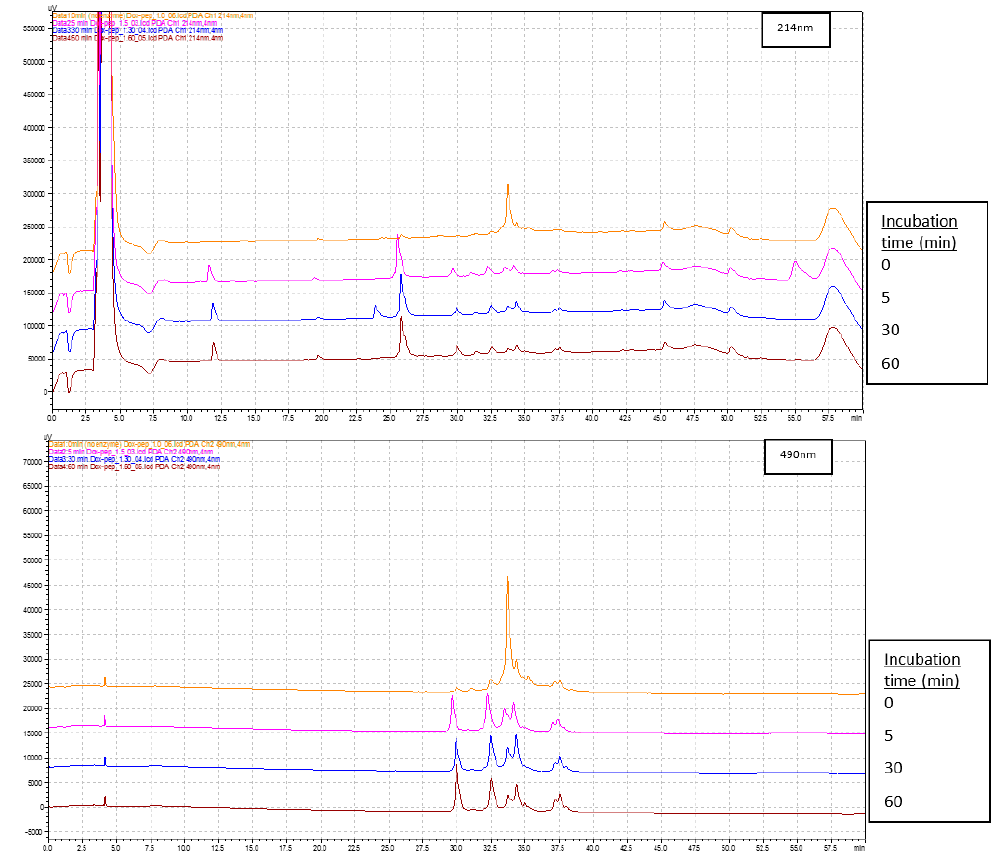
Figure 7. Analytical HPLC chromatogram over time for Dox-peptide conjugate 13 in human cathepsin B with absorbance detection at 214 nm ( top ) and 490 nm ( bottom ). Dox-peptide 13 retention time = 34 min. Dox alone retention time = 30 min. Note the similar shape of the 5, 30, and 60 min incubations. Also, the peak at ~30.5 min showed strong absorbance at both 214 nm and 490 nm.